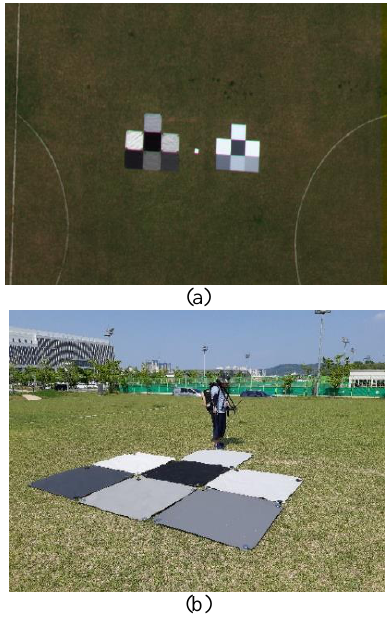
Figure 1. The reference targets installed for radiometric